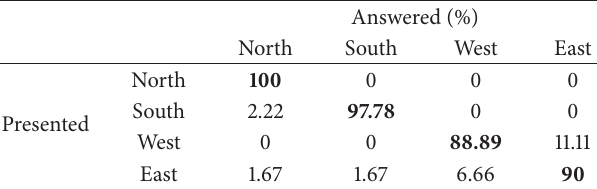
Table 3: Direction recognition rates with prototype